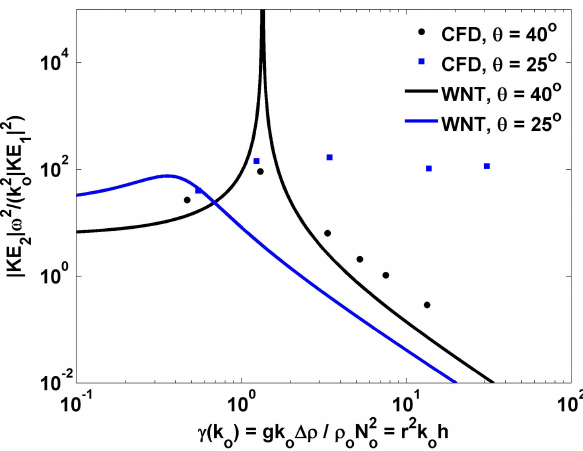
Figure 10. Comparison of the kinetic energy amplitudes in the har- monic mode between the simulations (symbols) and Eq. (13) (dot- ted lines) from the weakly nonlinear refraction